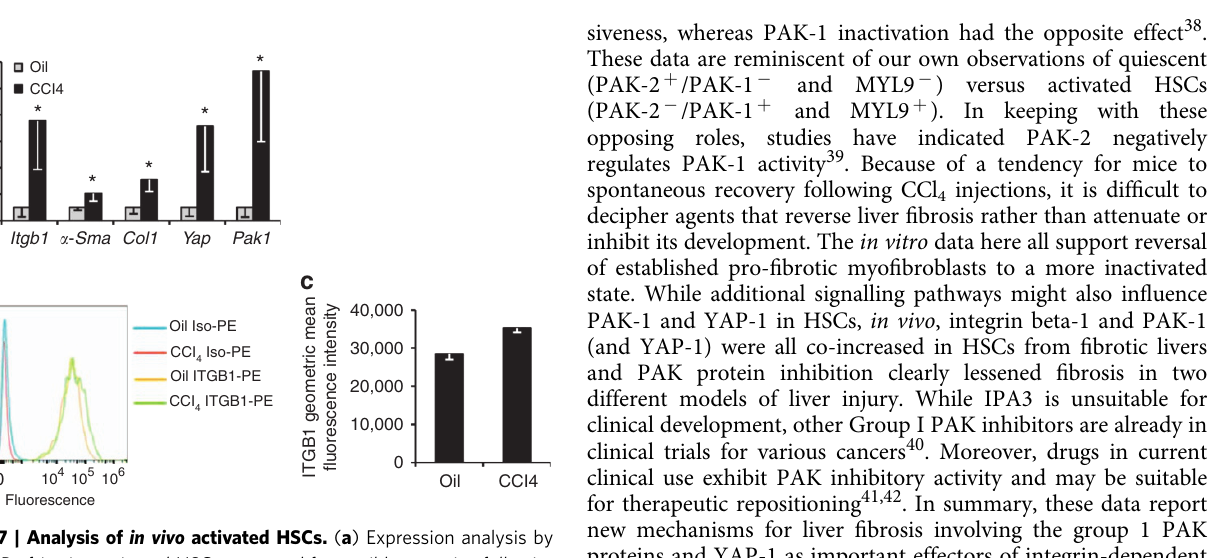
Figure 7 | Analysis of in vivo activated HSCs. ( a ) Expression analysis by qRT–PCR of in vivo activated HSCs extracted from wild-type mice following CCl 4 injections compared with olive oil control. ( b , c ) FACS analysis for integrin beta-1 on in vivo activated HSCs extracted from Pdgfrb-BAC-eGFP mice following CCl 4 -induced fibrosis compared with olive oil control. Fluorescence intensity is shown using a phycoerythrin (PE)-conjugated antibody to integrin beta-1 (integrin beta-1-PE) and isotype control (Iso-PE) ( b ). Graphical representation of integrin beta-1 fluorescence demonstrating increased integrin beta-1 on unpermeabilized live HSCs the context of liver fibrosis ( c ). All experiments are n ¼ 4. Two-tailed unpaired t -test was used for statistical analysis. Data in bar charts show means ± s.e.m. * P o 0.05, ** P o